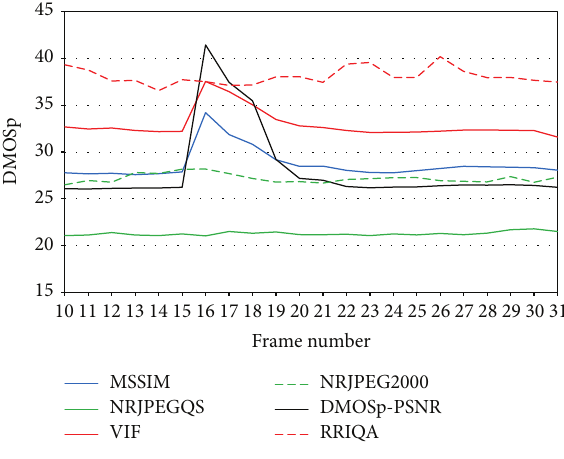
Figure 13: Metric comparison for an isolated